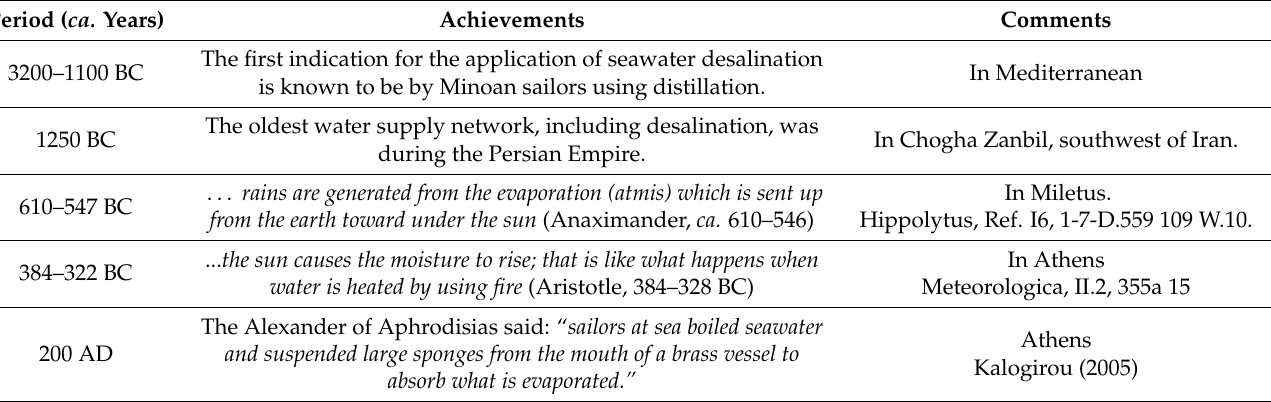
Table A1. A timeline in terms of the historical improvement of desalination